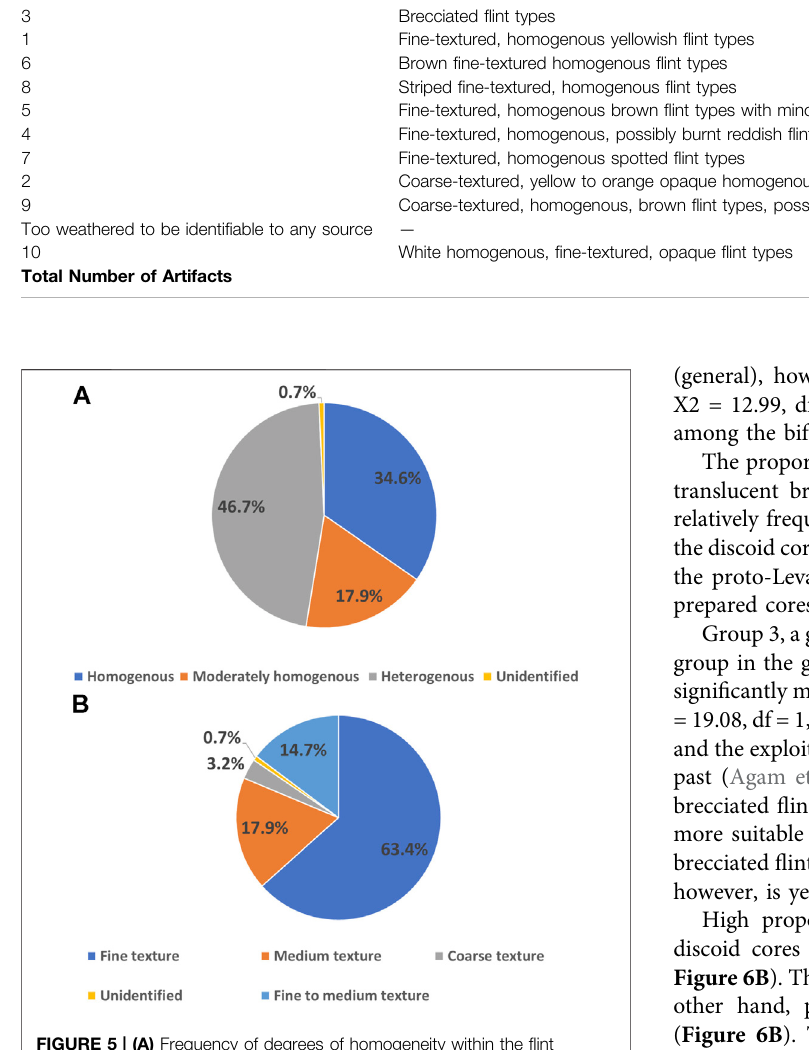
FIGURE 5 | (A) Frequency of degrees of homogeneity within the fl int types of the general sample; (B) Frequency of fl int ’ s texture within the general